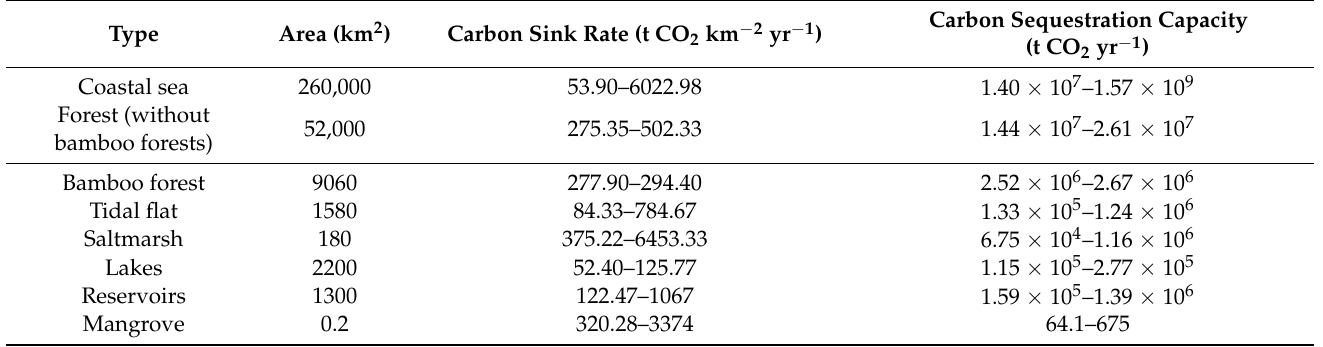
Table 1. A summary of terrestrial and marine carbon sinks in Zhejiang